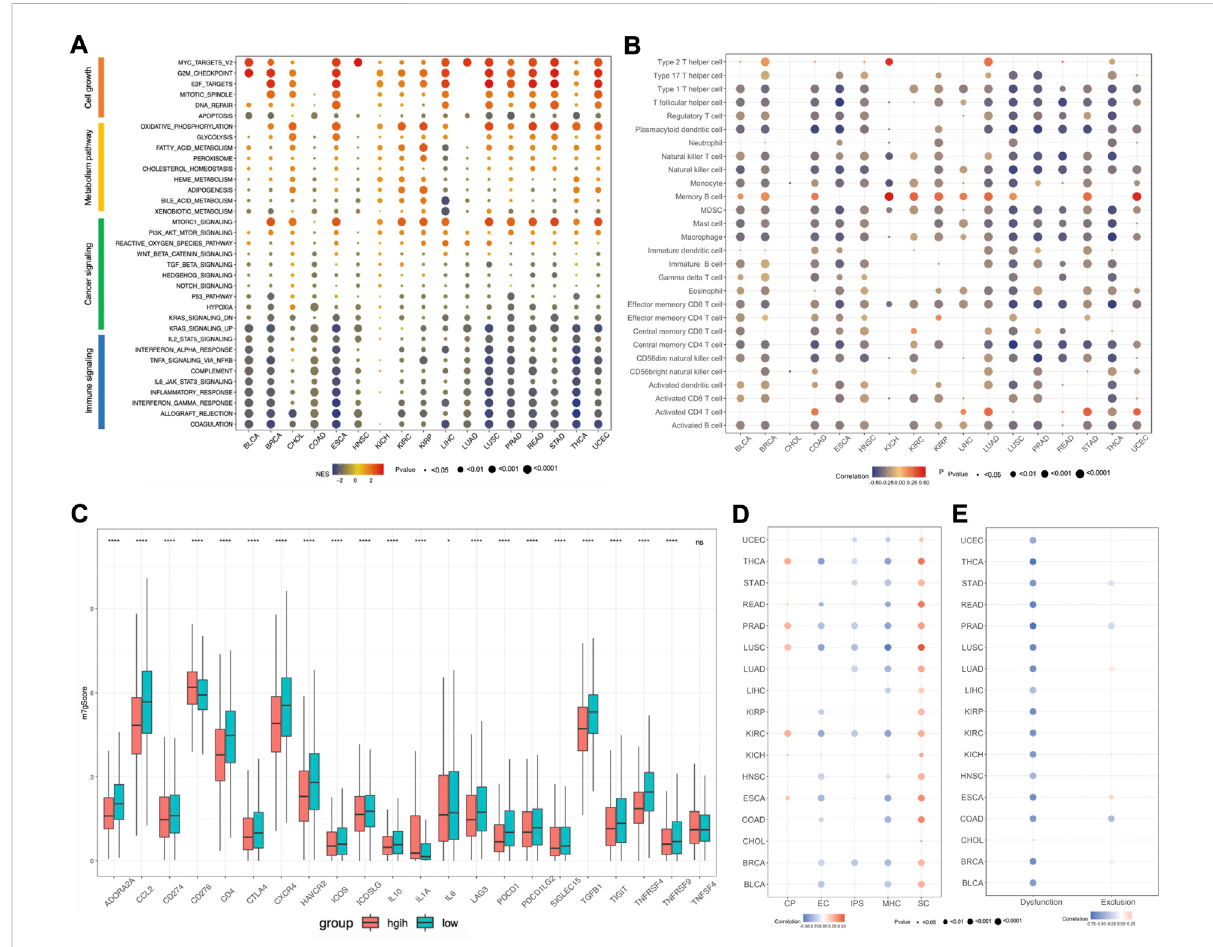
FIGURE 7 Association between m7Gscore and hallmark pathways, tumor immune microenvironment, immunotherapy response among cancers. (A) GSEA for hallmark pathways between top 30% and bottom 30% of m7Gscore in each cancer. (B) The correlation between m7Gscore and immune cells among cancers based on ssGSEA. (C) The differential analysis of immune checkpoint molecules between m7Gscore high-risk and low-risk groups in pan-cancers. (D) The correlation between m7Gscore and immunophenotypes calculated by TCIA database across cancers. (E) The correlation between m7Gscore and T cell dysfunction/exclusion score by TIDE database across